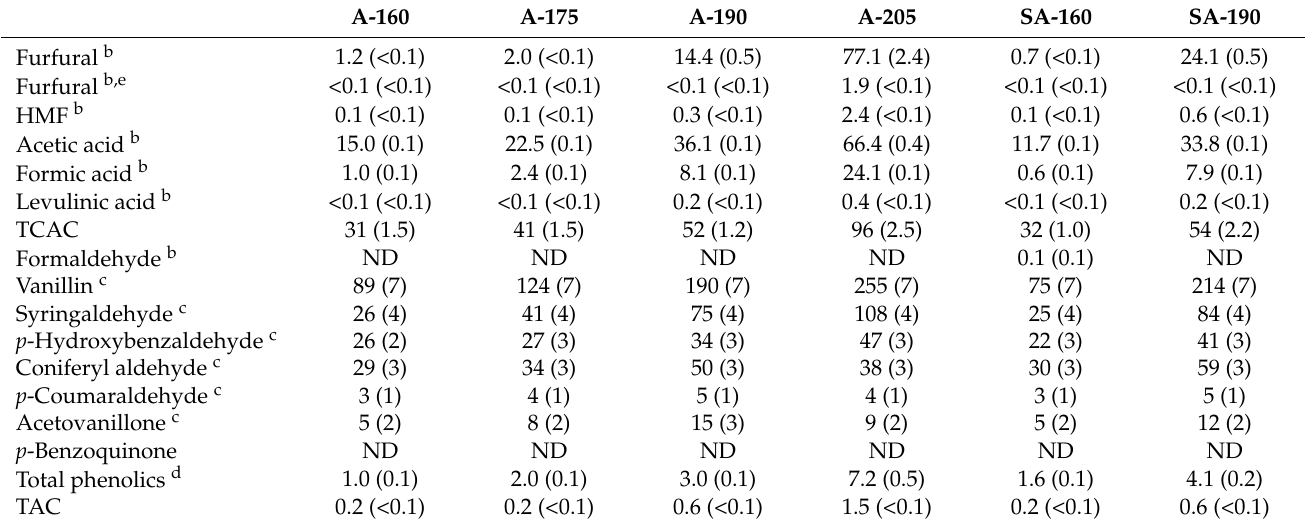
Table 4. Concentration of bioconversion inhibitors in the pretreatment liquids a .